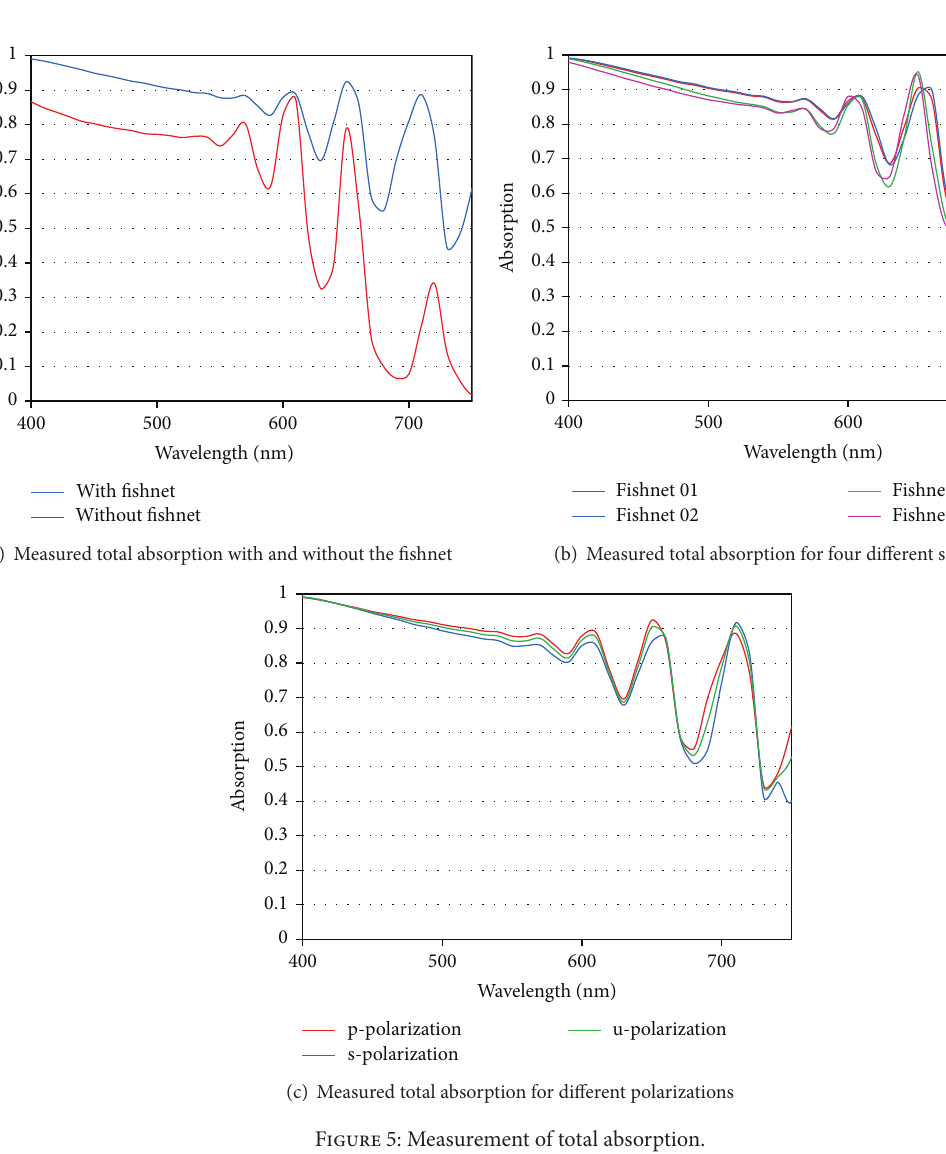
Table 1: Calculated 𝐽